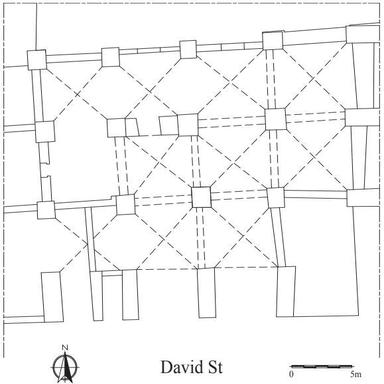
Plan of the groin vault system of St John Hospital.